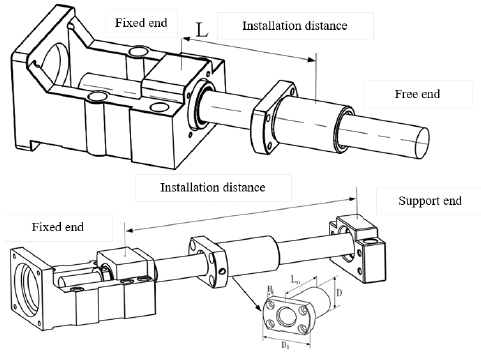
Figure 7. The installation method of screw shaft.